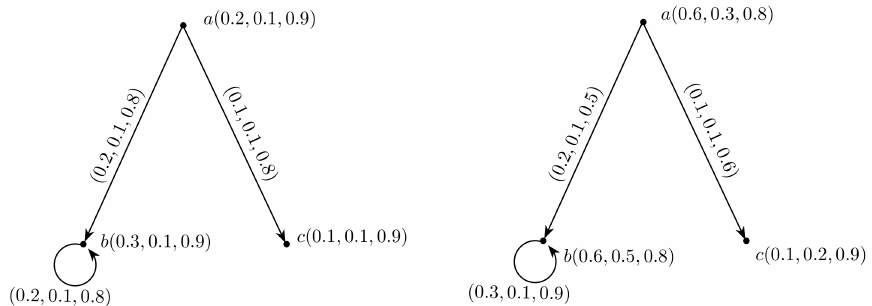
Figure 3. Rough neutrosophic digraph G 1 (cid:101) G 2 = ( G 1 ∩ G 2 , G 1 ∩ G 2 )